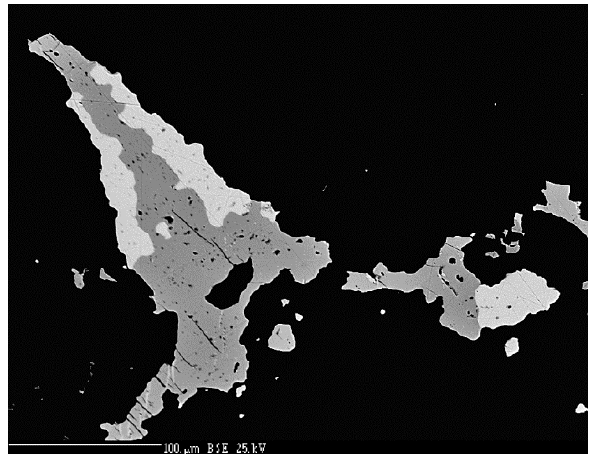
Figure 15. Brodtkorbite grains (grey) in association with tiemannite (white) in calcite gangue. BSE photo. P ř íbram, a dump of shaft 16. Photo by J. Sejkora.